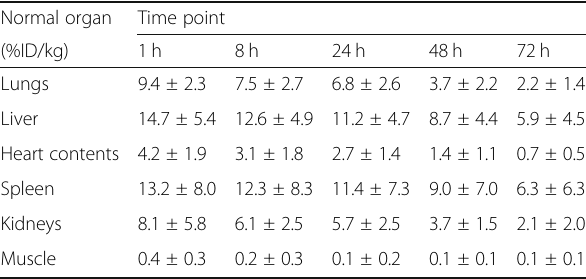
Table 3 Biodistribution for nano-carrier 188 Re-liposome in normal organs of patients ( n = 12) Normal organ